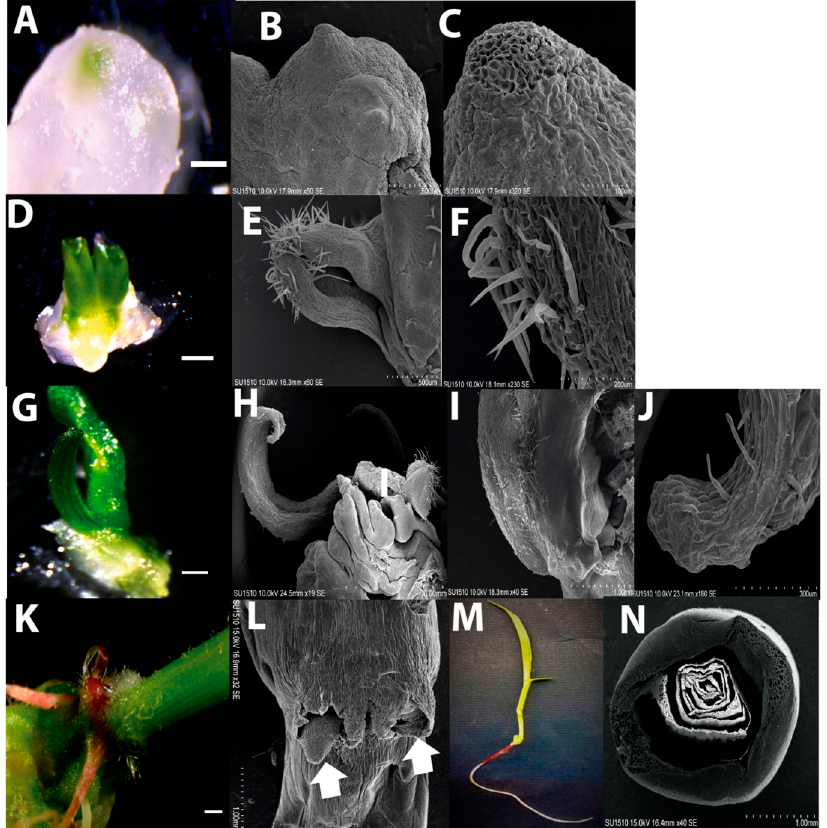
Figure 3. Developmental stages during Tuxpeño VS-535 plant regeneration from EC. ( A ) Regenerative spot observed on EC subcultured for two weeks in N6P with 50% hormones and photoperiod (1st stage). ( B ) The 1st stage of development observed with SEM. ( C ) Magnification of the regenerative spot tip with SEM. ( D ) Apical growth resembling leaf structure observed from a regenerative spot in N6P with 0% hormones (2nd stage). ( E ) The 2nd stage of development observed with SEM. ( F ) Magnification of the leaf-like structure exhibiting hairs the primordium. ( G ) Development of a differentiated leaf structure still adhered to the callus and without root emergence, in MS (3rd stage). ( H ) The 3rd stage of development observed with SEM. ( I ) Magnification of the basal portion of the leaf observed with SEM. ( J ) Magnification of the tip portion of the leaf observed with SEM. ( K ) The stem portion of a regenerated plantlet with visible roots grown in MS. ( L ) Roots emerging from the regenerated plantlet observed with SEM. Two arrows point at emerging roots. ( M ) Whole regenerated plantlet. ( N ) Cross section at the base of a plantlet stem observed with SEM. In A , D , G and K Bar= 1 mm.